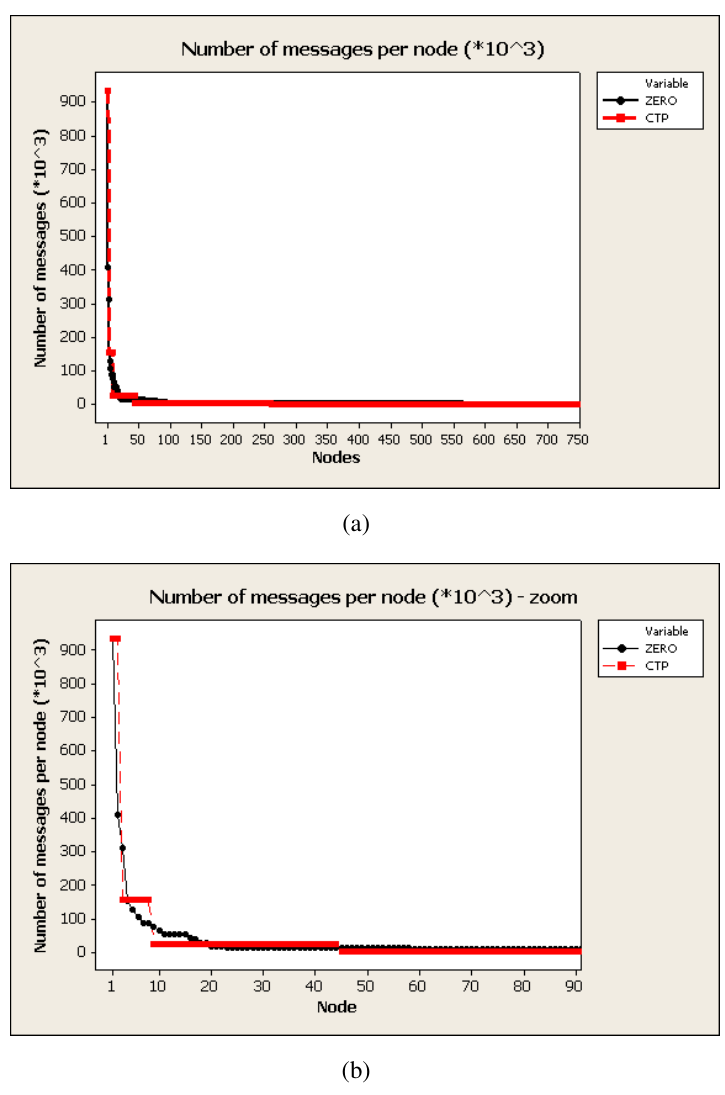
Figure 4. Number of messages routed per node. X-axis show nodes descending sorted by the number of messages routed. Node 1 represents the root node as it routes all messages generated in the network. (a) Distribution of number of messages routed per each node, (b) Zoom in of the previous image.